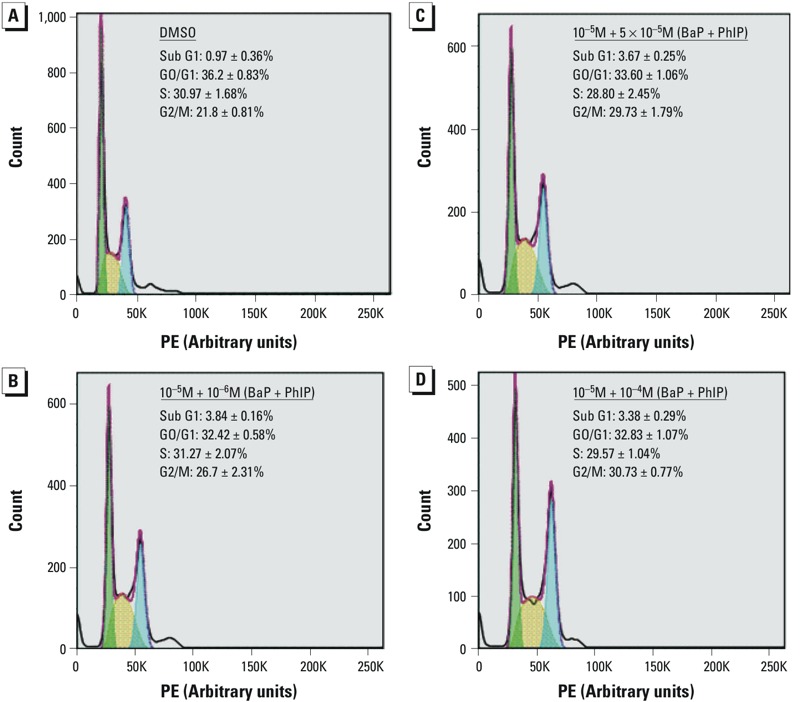
Effects of mixtures of BaP and PhIP on cell cycle. Percentage of cells in each phase of the cell cycle after a 24-hr treatment with (A) dimethylsulfoxide (DMSO; negative control) or with (B, C, D) selected combinations of BaP and PhIP followed by a 24-hr recovery period. Assessed by flow cytometry.
PE, propidium iodide staining.